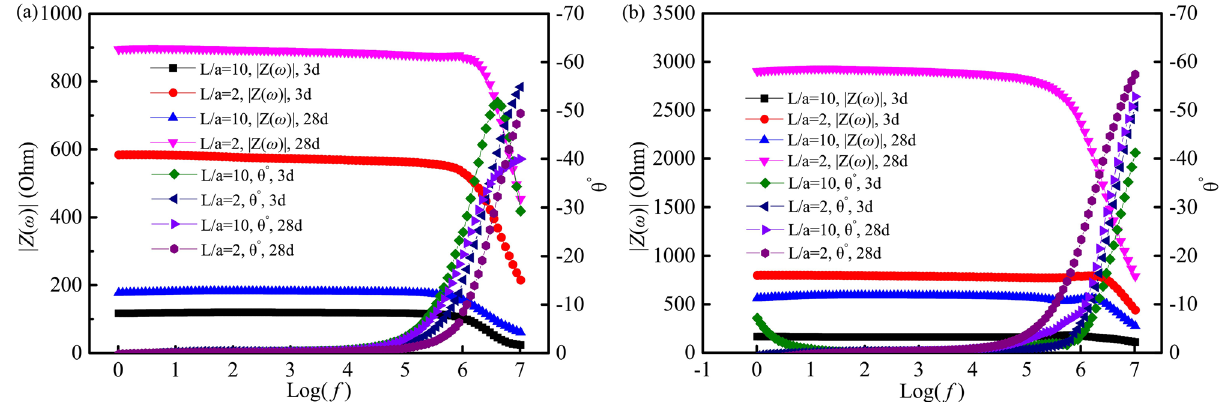
Figure 9. Bode plots of ACIS with L / a = 2 and 10 measured by four-point measurement. ( a ) In the fog room curing condition; ( b ) Indoor curing condition.